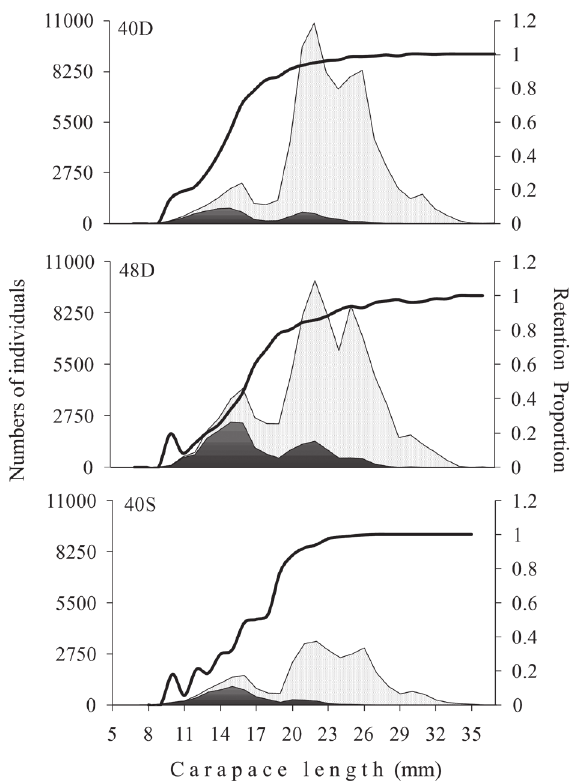
Fig. 2. – numbers of size distributions of specimens that entered (grey area) and escaped (black area) for 40d (40 mm diamond mesh), 48d (48 mm diamond mesh), and 40s (40 mm square mesh) codends. dark black lines show the retention proportions in these